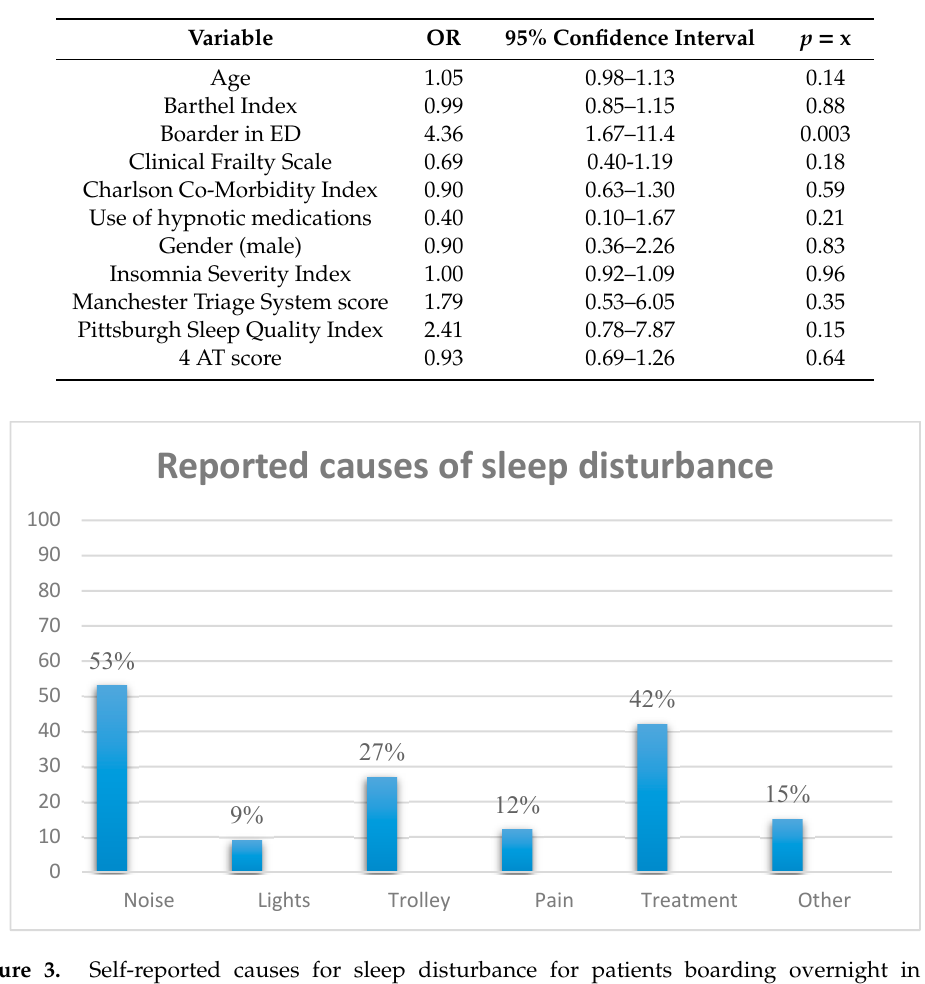
Table 2. Binary logistic regression model showing the association, odd ratio (OR), between variables including boarding in the emergency department (ED) and poor overnight sleep based on a Richards Campbell Sleep Questionnaire cut-o ff score of < 70.